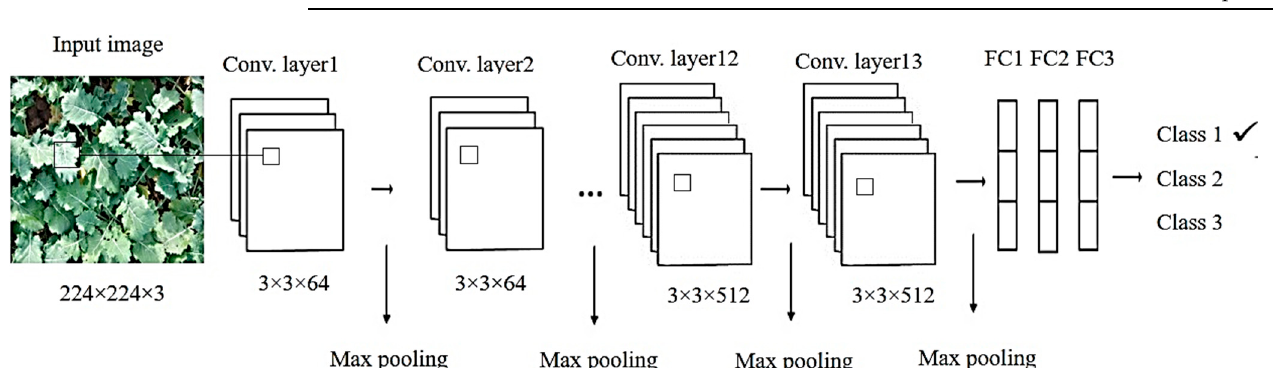
Figure 4. Architecture of Vgg16 for classification of damaged rapeseed crop.